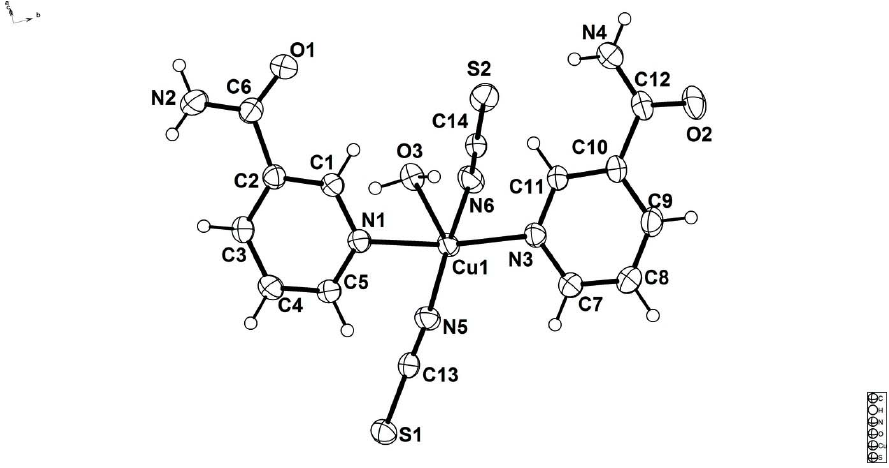
Figure 1 The molecular structure of (I) with displacement ellipsoids drawn at the 40% probability level (arbitrary spheres for the H